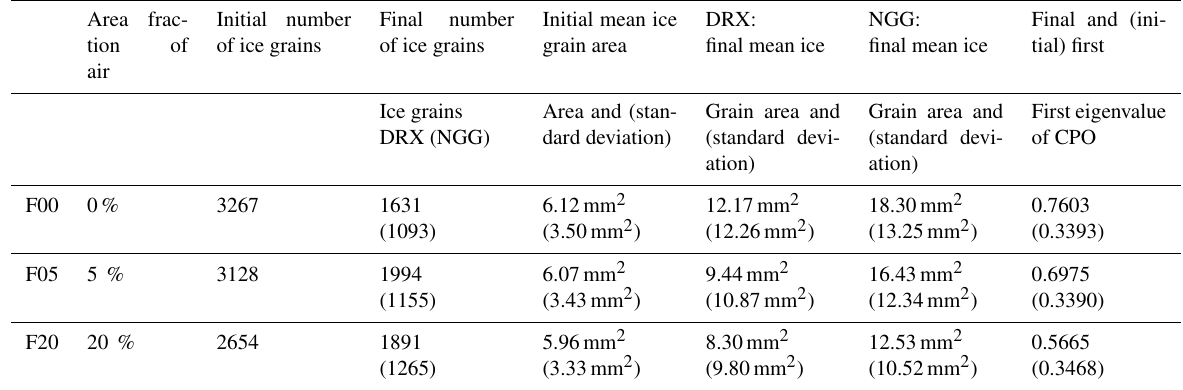
Table 2. Overview on numerical simulations using crystal viscoplasticity and dynamic recrystallization (DRX) and only normal grain growth (NGG) simulations. NGG simulations used the same initial microstructures than DRX